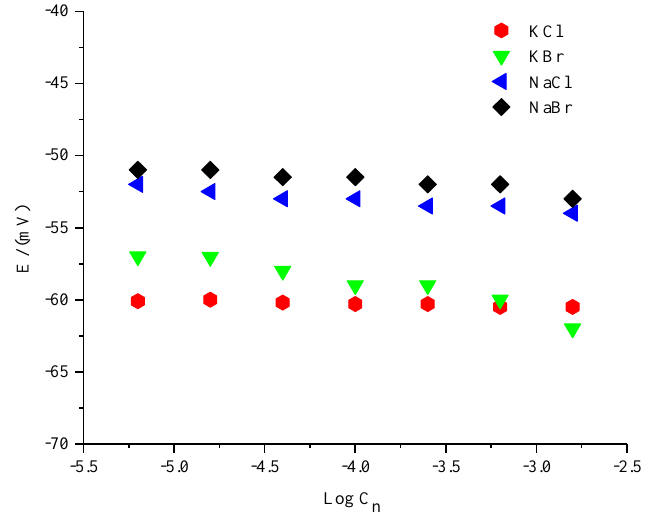
Figure 4. Potential dependency profile of the fabricated microelectrode as a function of the log concentration of different salts in the presence of 1.0% ethaline in 20 mM Na 2 SO 4 .